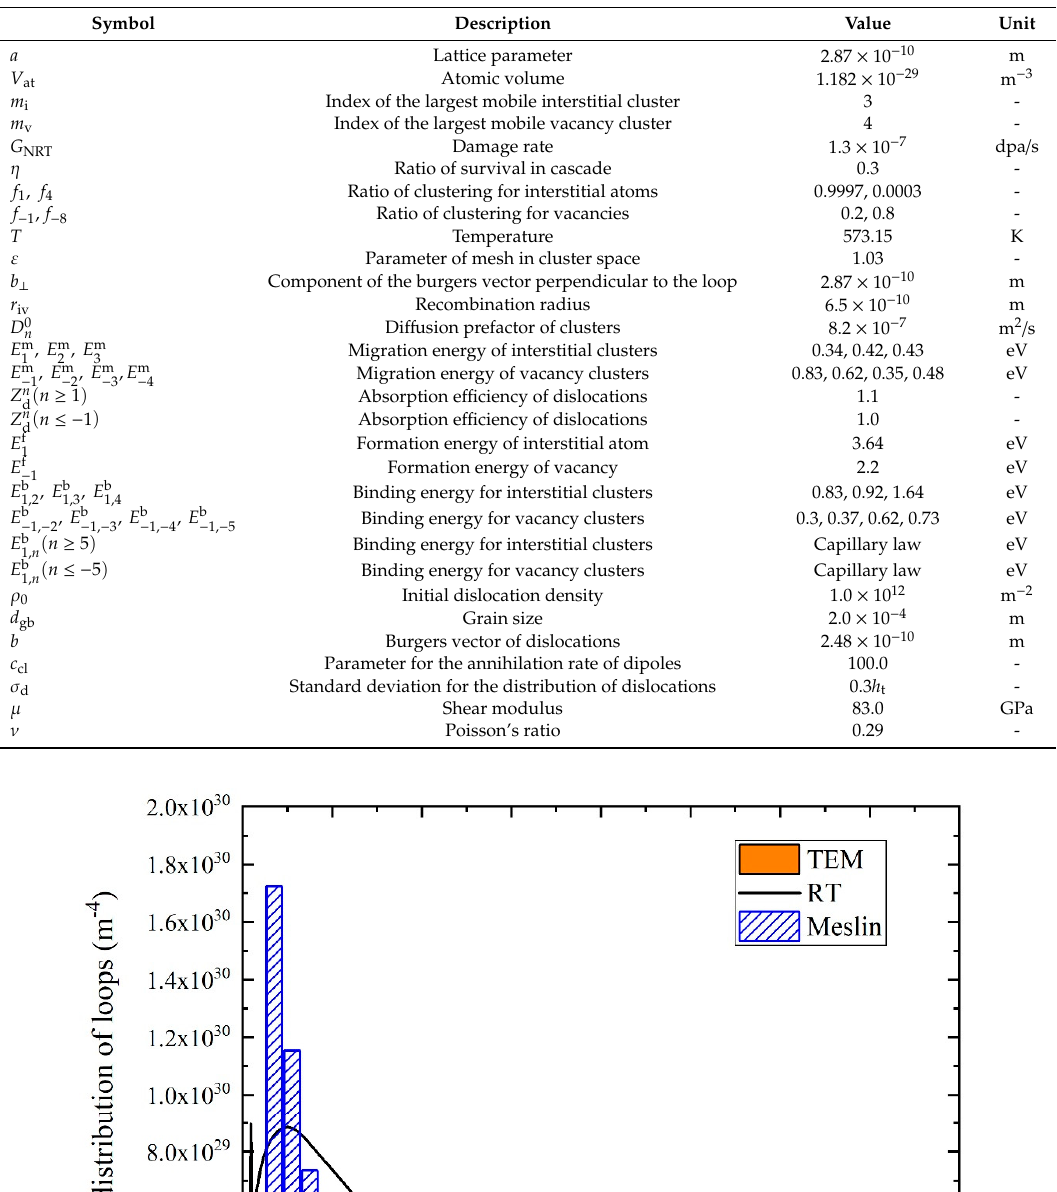
Table 1. Parameters used for the simulation of pure iron under neutron irradiation.